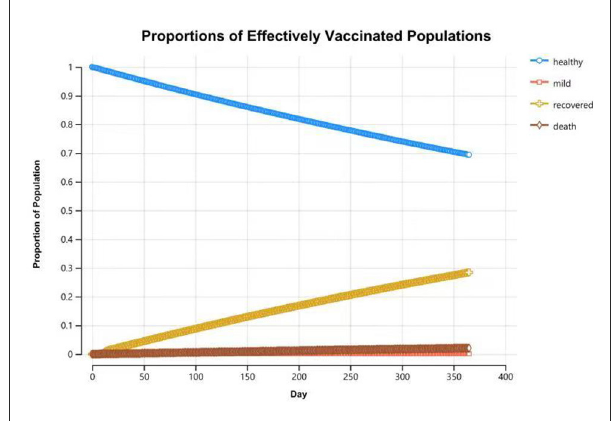
FIGURE4 Proportions of populations by health states in the “effectively vaccinated” arm at the end of 1-year time